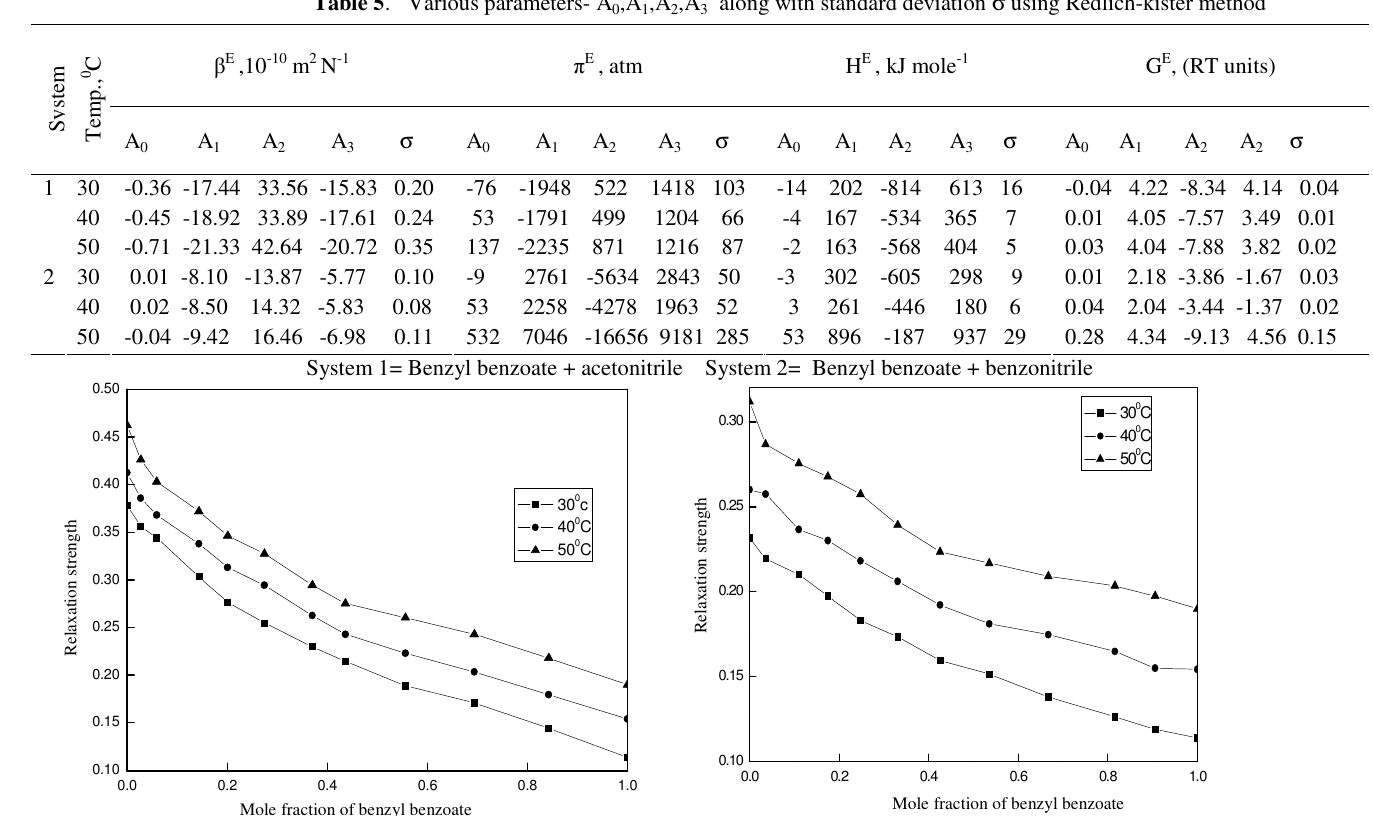
Figure 1(g). Variation of relaxation strength with mole fraction of benzyl benzoate in the mixture of benzyl benzoate+acetonitrile